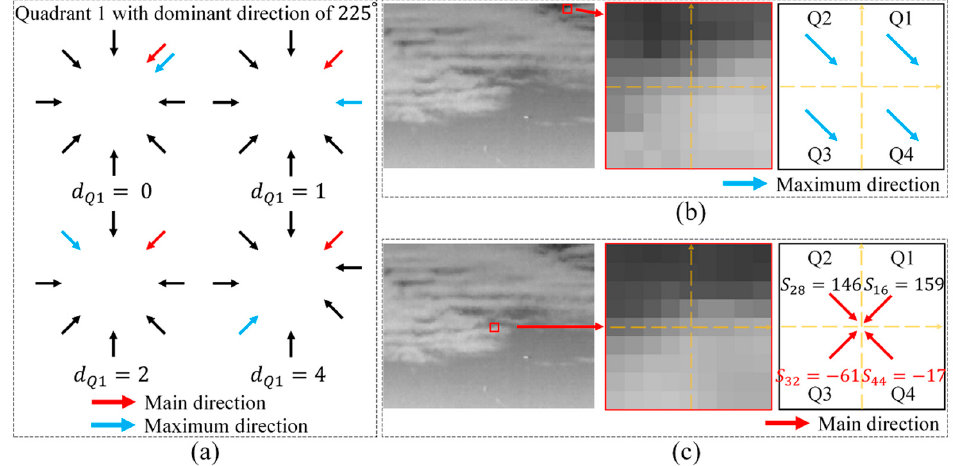
Figure 6. ( a ) Illustration of index distance calculation for quadrant 1 in different situations; ( b ) example of the four quadrants having the same maximum gradient directions; ( c ) example of dominant direction of two quadrants having a negative gradient score.